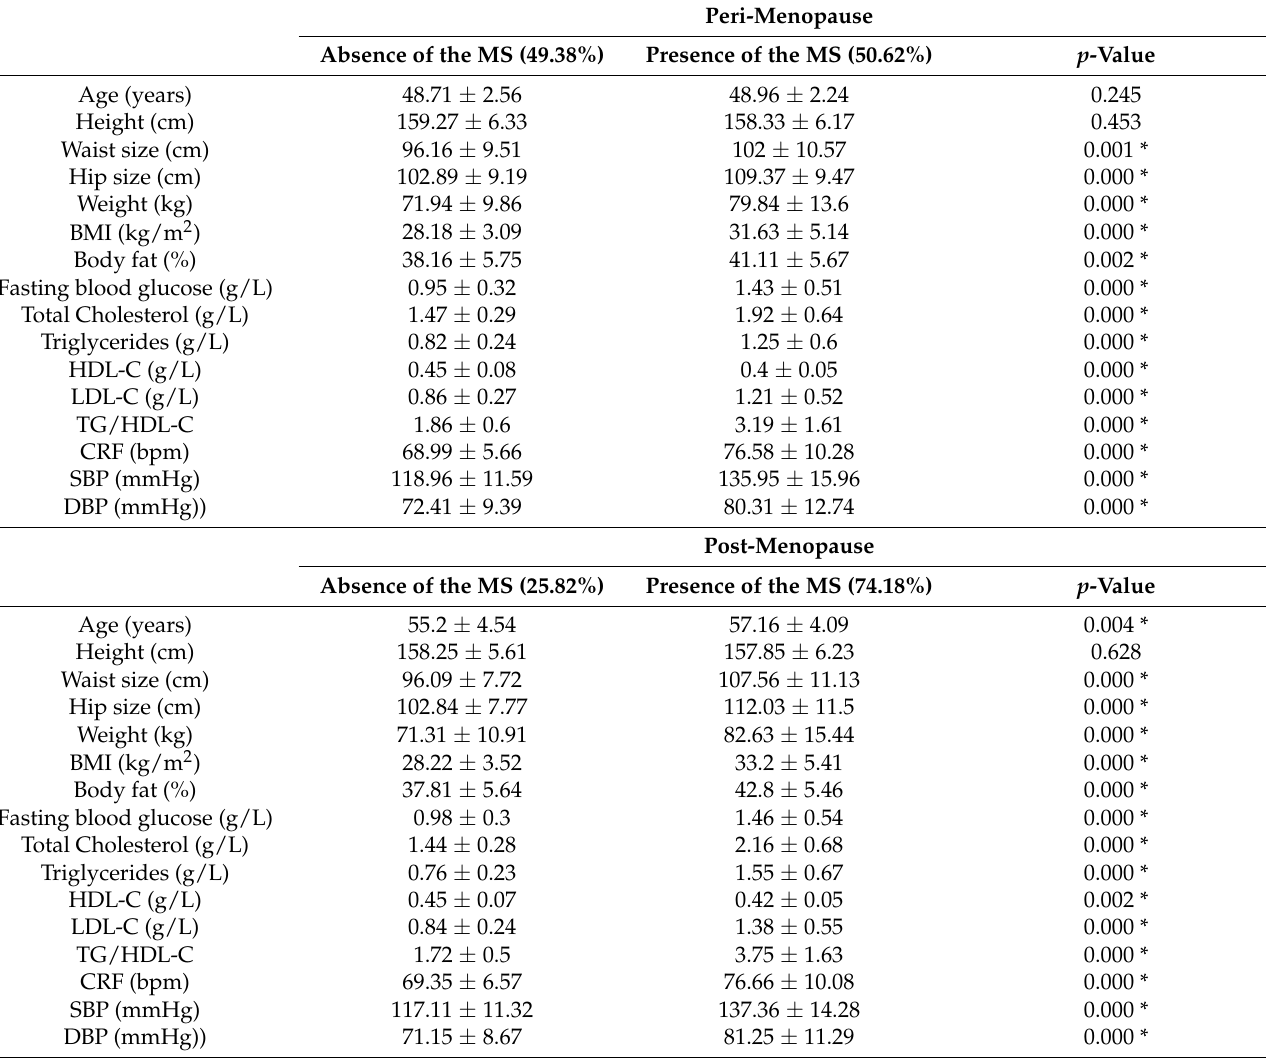
Table 2. Biological characteristics in peri- and post-menopausal women grouped according to metabolic syndrome (NCEP criteria). Peri-Menopause Absence of the MS (49.38%) Presence of the MS